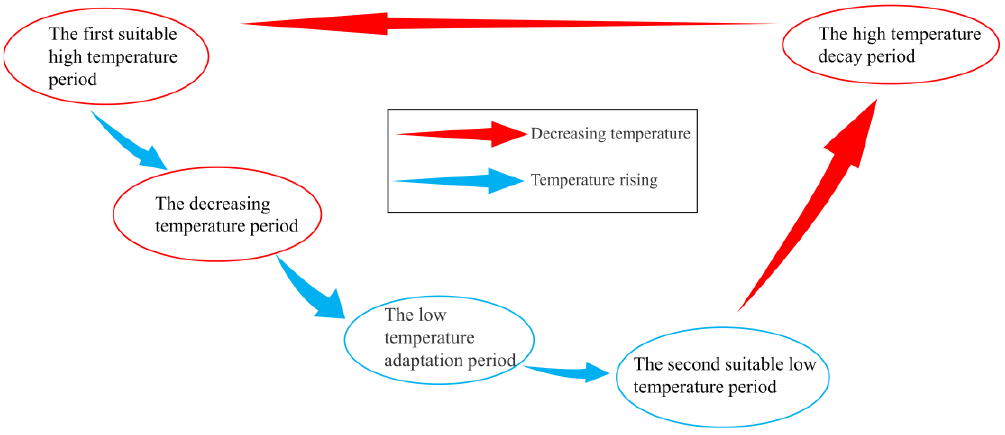
Figure 8. Growth stages of S. horneri .